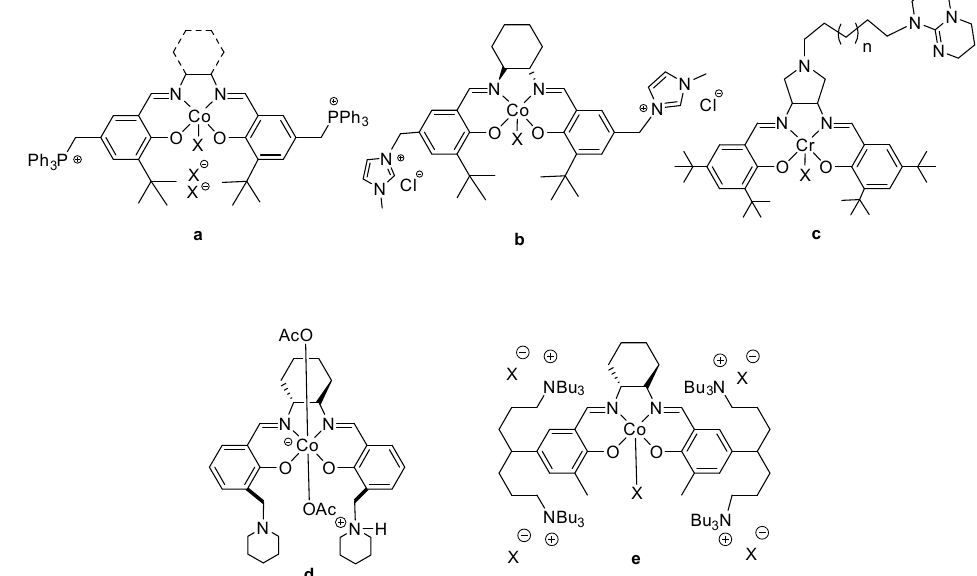
Figure 2. Bifunctional catalysts reported for CO 2 /epoxides coupling reactions. Catalyst prepared by: ( a ) He et al., 2008 [23] and Jing et al., 2009 [24]; ( b ) Jing et al., 2009 [24]; ( c ) Sun et al., 2008 [22]; ( d ) Nozaki et al., 2006 [30]; ( e ) Lee, et al., 2008 [31].